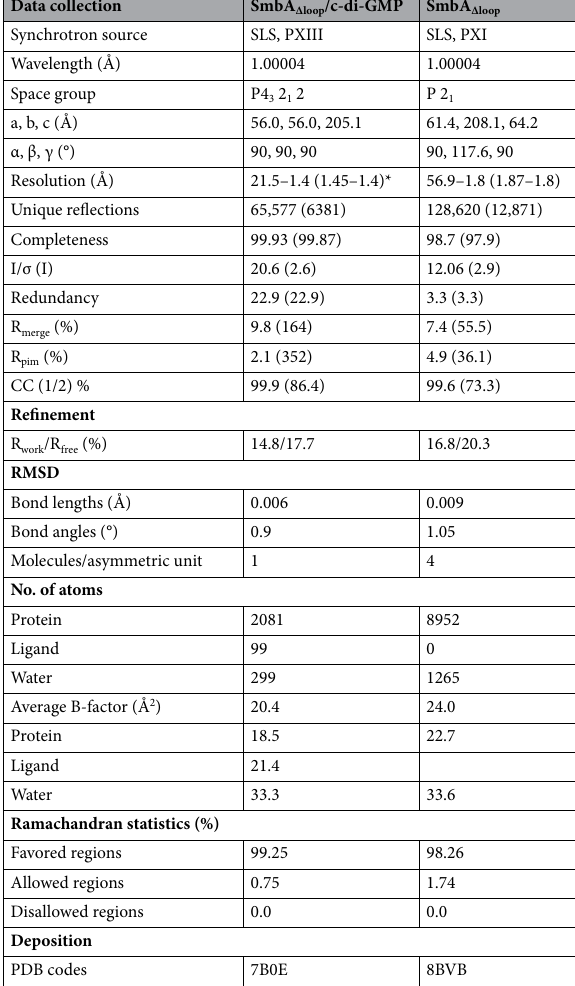
Table 1. Crystallographic data collection and refinement statistics. (* = The values recorded in parentheses are those for the highest resolution